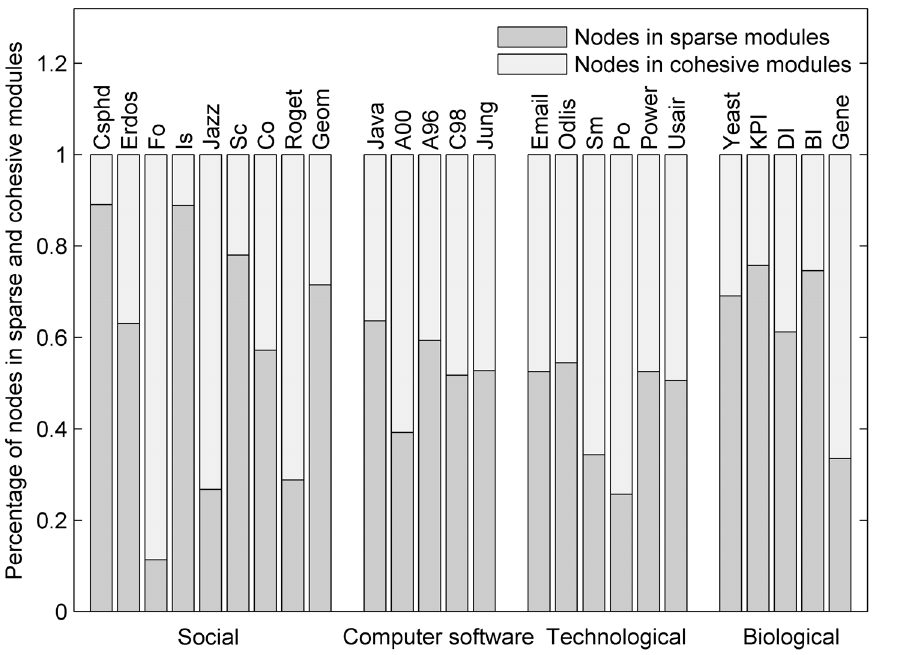
Figure 3. The relative proportions of nodes in different networks from sparse and cohesive modules detected by BTS method.